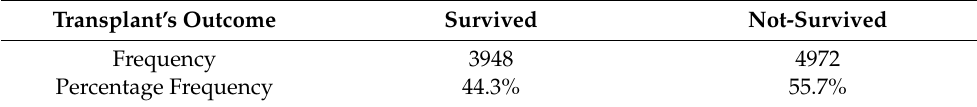
Table 6. Frequency distribution of 10-year survival outcomes of transplants.